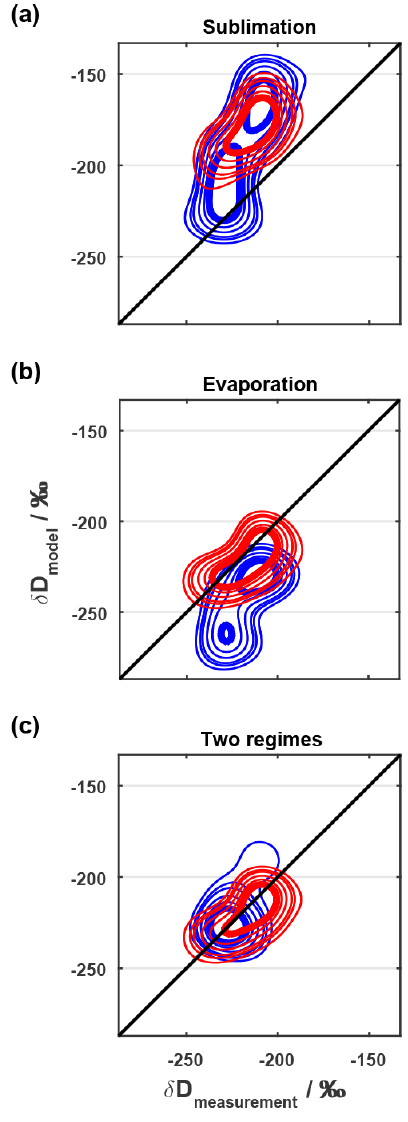
Figure 9. Two-dimensional probability distributions of measured and modeled δ D of low-level water vapor in Karlsruhe for selected cold snap events. Red: group “warm”; blue: group “cold”. Prob- abilities were calculated for a 20‰ × 20‰ δ D grid, smoothed with a 20‰ broad rectangle kernel, and finally interpolated to a 1‰ × 1‰ grid. Probabilities are normalized to 1 at the maximum; contours show probability levels of 0.8, 0.7, 0.6, 0.45, 0.35. (a) The model assumes sublimation of snow (no isotope fractionation) in the case of moisture uptake and skin temperature ( T skin ) below 0 ◦ C. (b) The model assumes evaporation of melted snow (equi- librium isotope fractionation) in the case of moisture uptake and T skin < 0 ◦ C. (c) The model assumes sublimation of snow in the case of moisture uptake and T skin < − 7 . 7 ◦ C. In the case of mois- ture uptake and − 7.7 ◦ C < T skin < 0 ◦ C the model assumes evapo- ration of melted